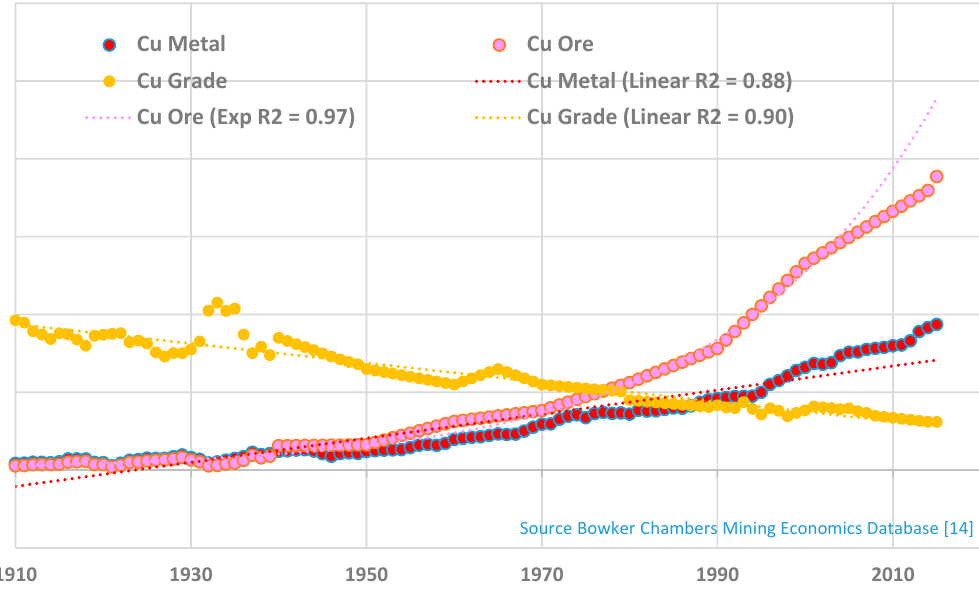
Figure 4. The shift in the mining metric from throughput to grade.